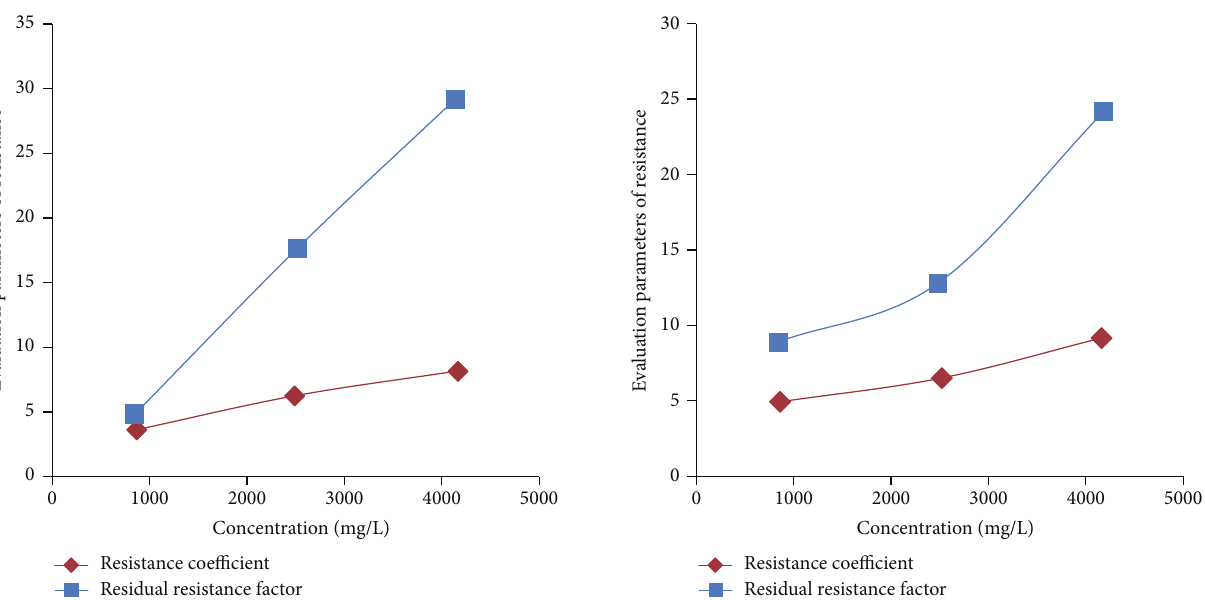
Figure 7: Relationship between resistance evaluation parameters and asphalt particles concentration (1000mD).